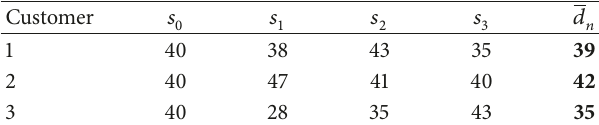
Table 2: Numerical example.